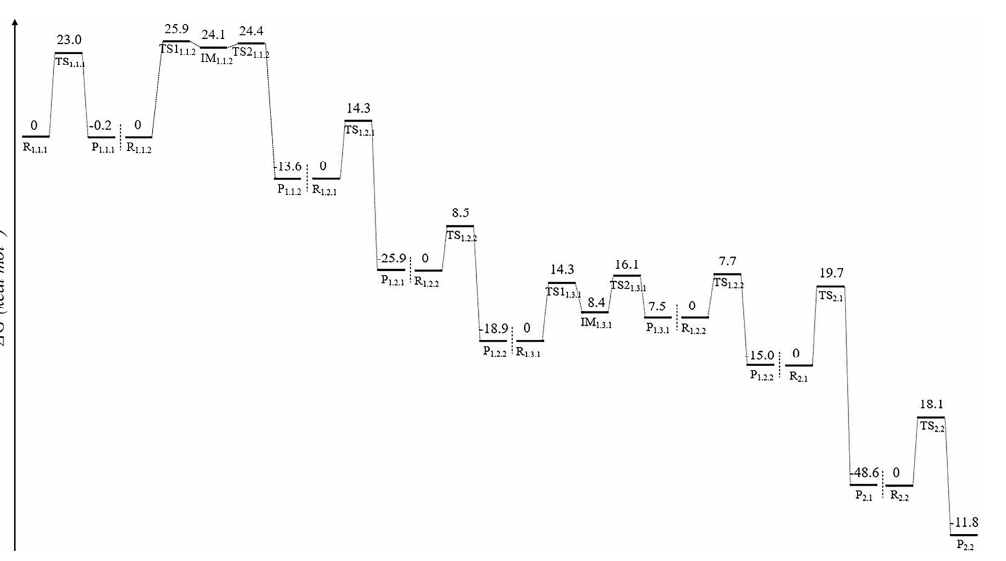
Figure 4. Under the calculated level of CAM-B3LYP/6 − 31+G**, ( a ) the reaction potential energy curve and the key geometric parameters of each stable point of ( a ) the hydroxylation process of hispidin (2.1) and ( b ) the isomerization process of 3-hydroxyhispidin (2.2). The reaction mechanism can be seen in Schemes 3–6. Group G 1 is shown in Scheme 1.